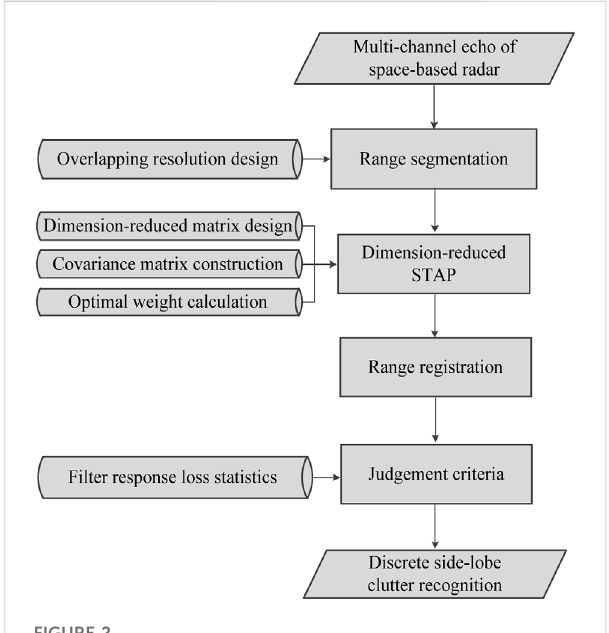
FIGURE 2 Flow chart of discrete side-lobe clutter recognition